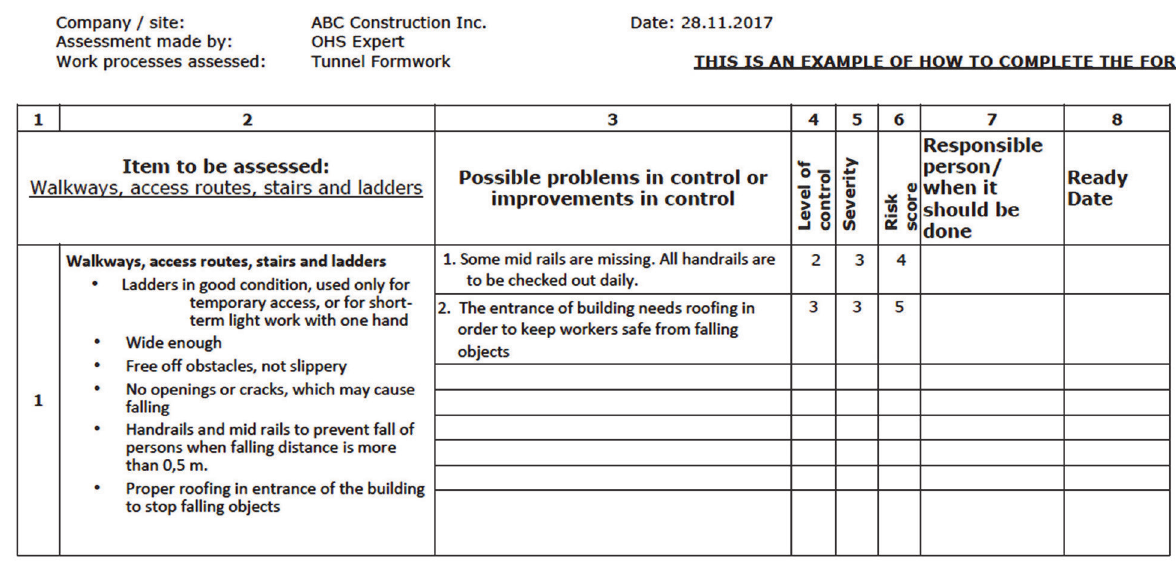
Figure 2. Sample assessment for the risk